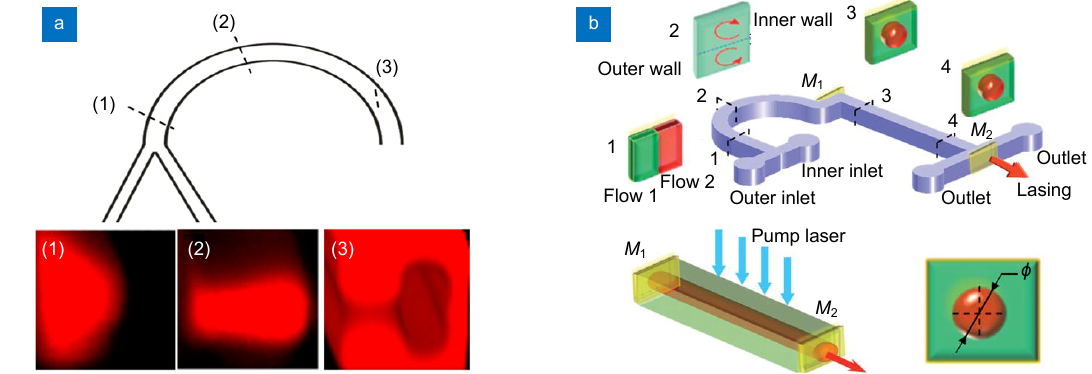
Fig. 2 | ( a ) The schematic of 3D liquid remodelability in a curved channel by centrifugal effect. ( b ) A 3D optofluidic dye laser. Figure reproduced from: ( b ) ref. 15 , The Royal Society of Chemistry.